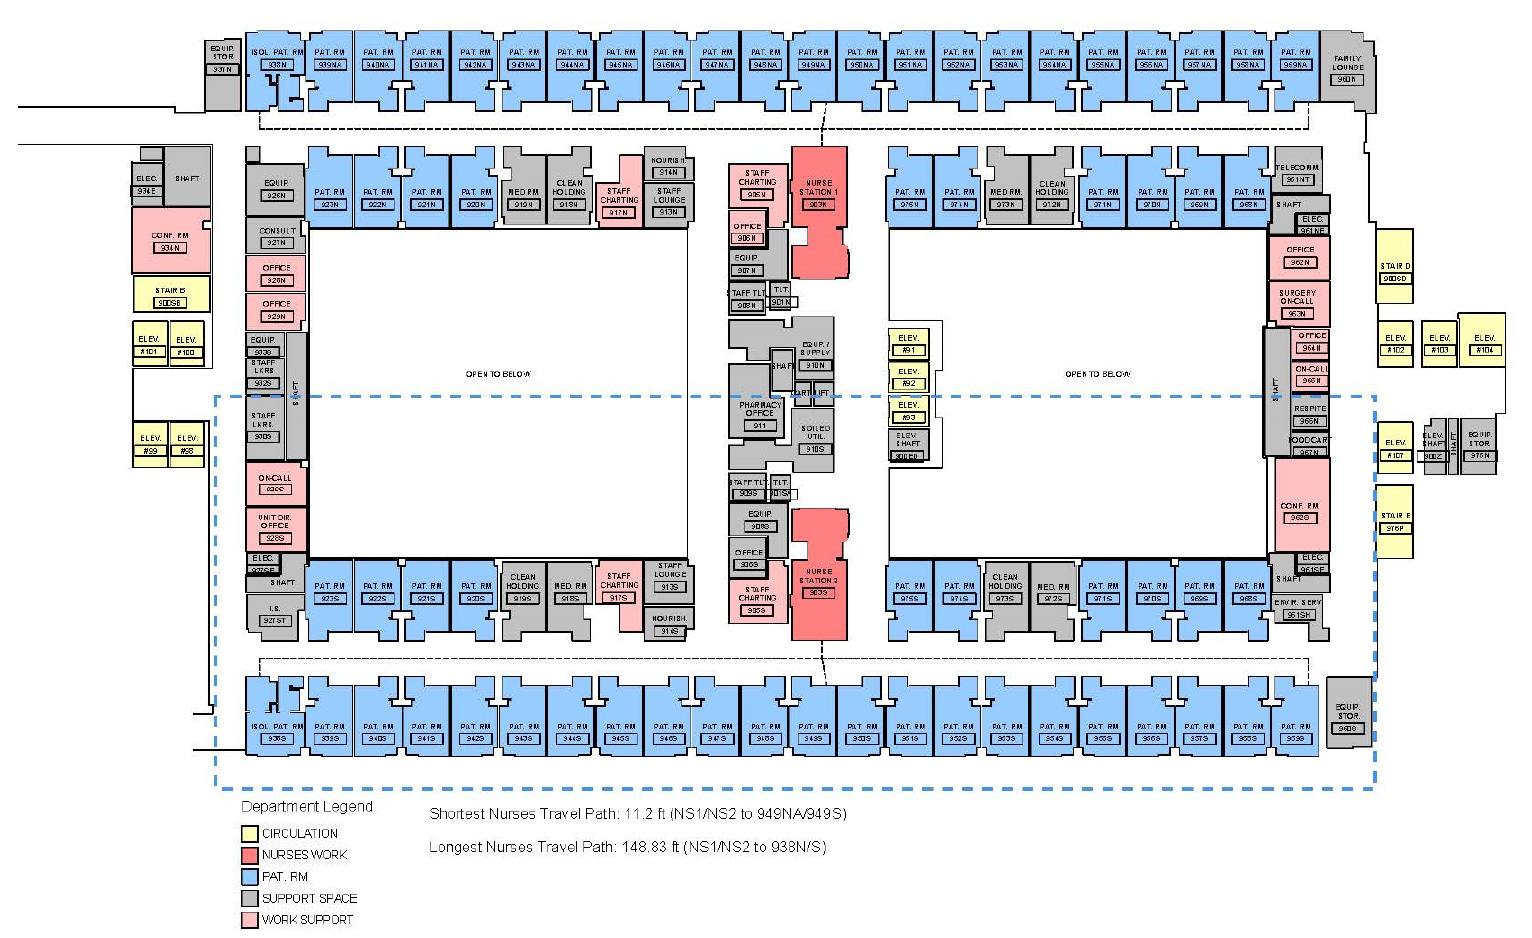
Figure 1. Floor plan of the 9 South in the Atrium building (Image Courtesy: RUMC, designed by Hansen Lind Meyer, plan re-drawn by the research team). Please see the dotted lines for area related to study and the drawing is not to scale.